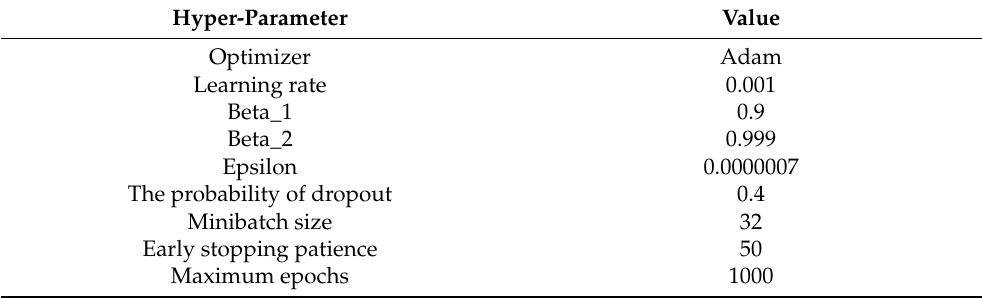
Table 2. The experimental setup.